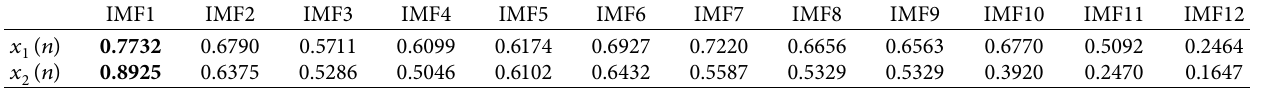
Table 2: Pearson’s correlation coefficient between a raw vibration signal and each of its IMFs